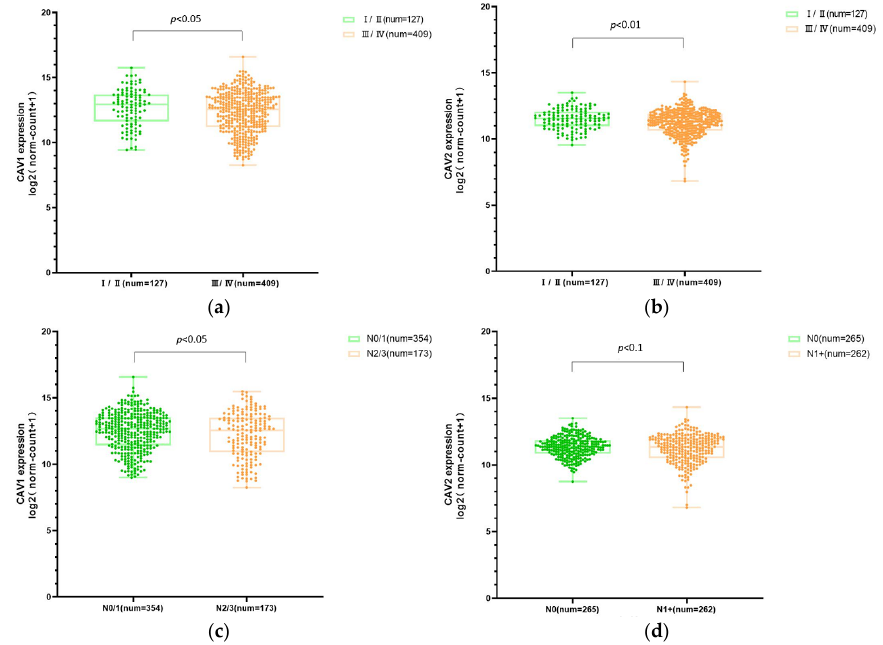
Figure 3. CAV1 and CAV2 mRNA expression levels are associated with multiple clinical pathological features. The box plot chart shows the comparison of mRNA expression levels of CAV1 and CAV2 in HNSCC cases grouped in accordance with clinical stages (( a ), mean ± SD: Ⅰ / Ⅱ : 12.66 ± 1.365, Ⅲ / Ⅳ : 12.32 ± 1.598; ( b , mean ± SD: Ⅰ / Ⅱ : 11.50 ± 0.783, Ⅲ / Ⅳ : 11.22 ± 0.983) and nodal invasion status (( c ), mean ± SD: N0/1:12.49 ± 1.448, N2/3: 12.19 ± 1.723; ( d ), mean ± SD: N0: 11.36 ± 0.765, N1+: 11.21 ± 1.095). N0, nodal negative; N1+, N1/2/3 cases.